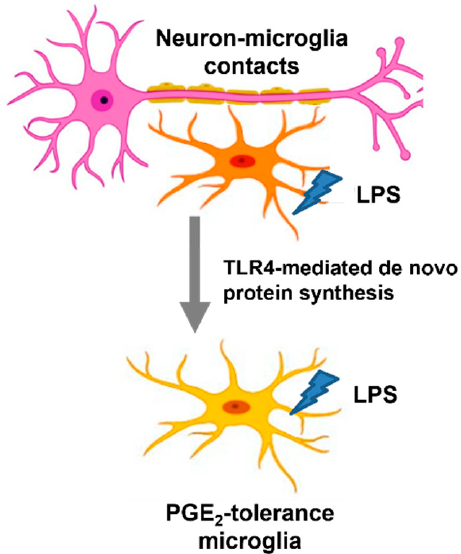
Figure 5. Indispensable role of neuron–microglia contacts for PGE 2 tolerance via TLR4-dependant de novo protein synthesis. Schematic of neuron–microglia contacts alter the immune property of microglia for development of PGE 2 tolerance via TLR4-derived de novo protein synthesis under ET challenge. Without neural contacts, microglia alone or cultured with astroglia or incubated with neural soluble factors fail to show endotoxin tolerance of PGE 2 .